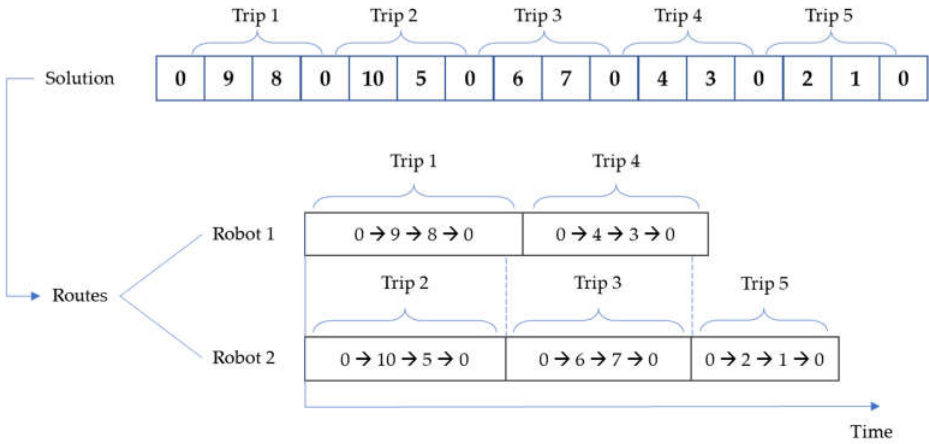
Figure 5. Example of how to convert the obtained solution to the robot route plans.